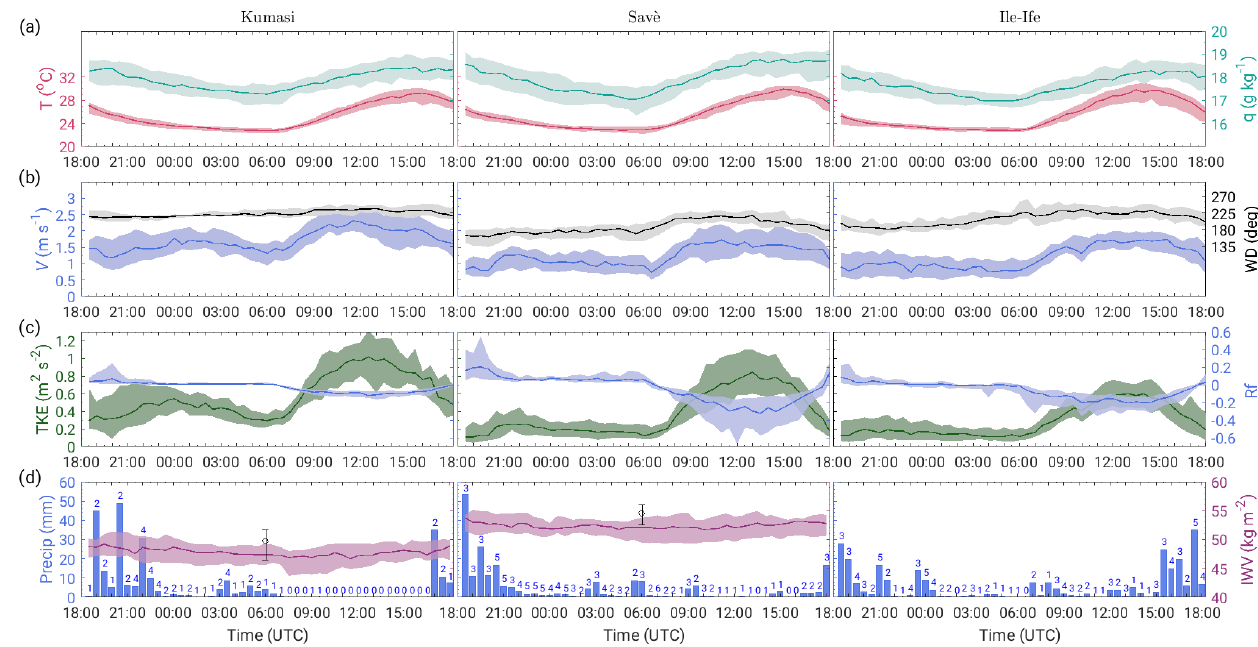
Figure 7. Median diurnal cycles of (a) specific humidity, q , and temperature, T ; (b) wind speed, v , and wind direction, WD; (c) turbulent kinetic energy, TKE, and flux Richardson number, Rf ; and (d) integrated water vapour, IWV, for Kumasi (left), Savè (middle) and Ile- Ife (right). The shaded areas represent the interquartile ranges. In (d) , the additional observation at 06:00UTC indicates median IWV and interquartile ranges from radiosonde measurements at Kumasi and Savè, respectively, and half-hourly precipitation sums accumulated over the whole measurement period are shown (numbers indicate the number of days on which precipitation